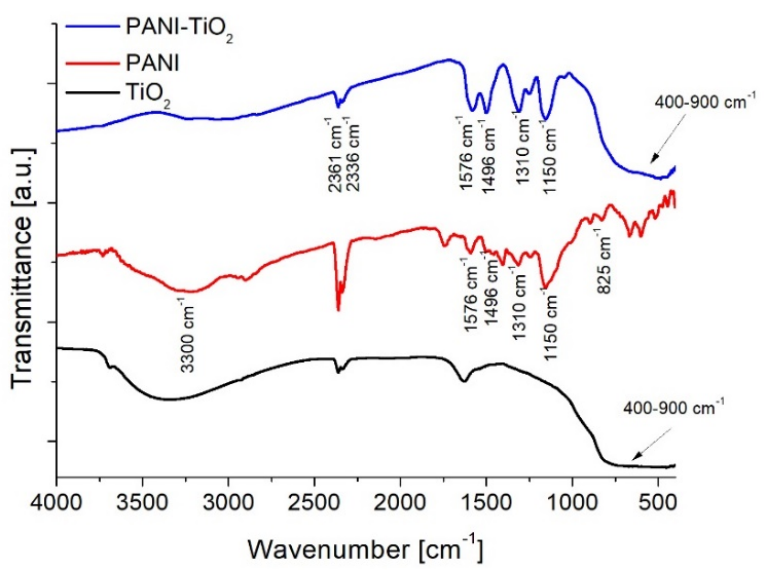
Figure 1. Fast-Fourier transformation spectroscopy (FTIR) spectra of TiO 2 , polyaniline (PANI), and PANI–TiO 2. Table 1. Crystalline structure and BET surface area of TiO 2 , PANI, and PANI–TiO